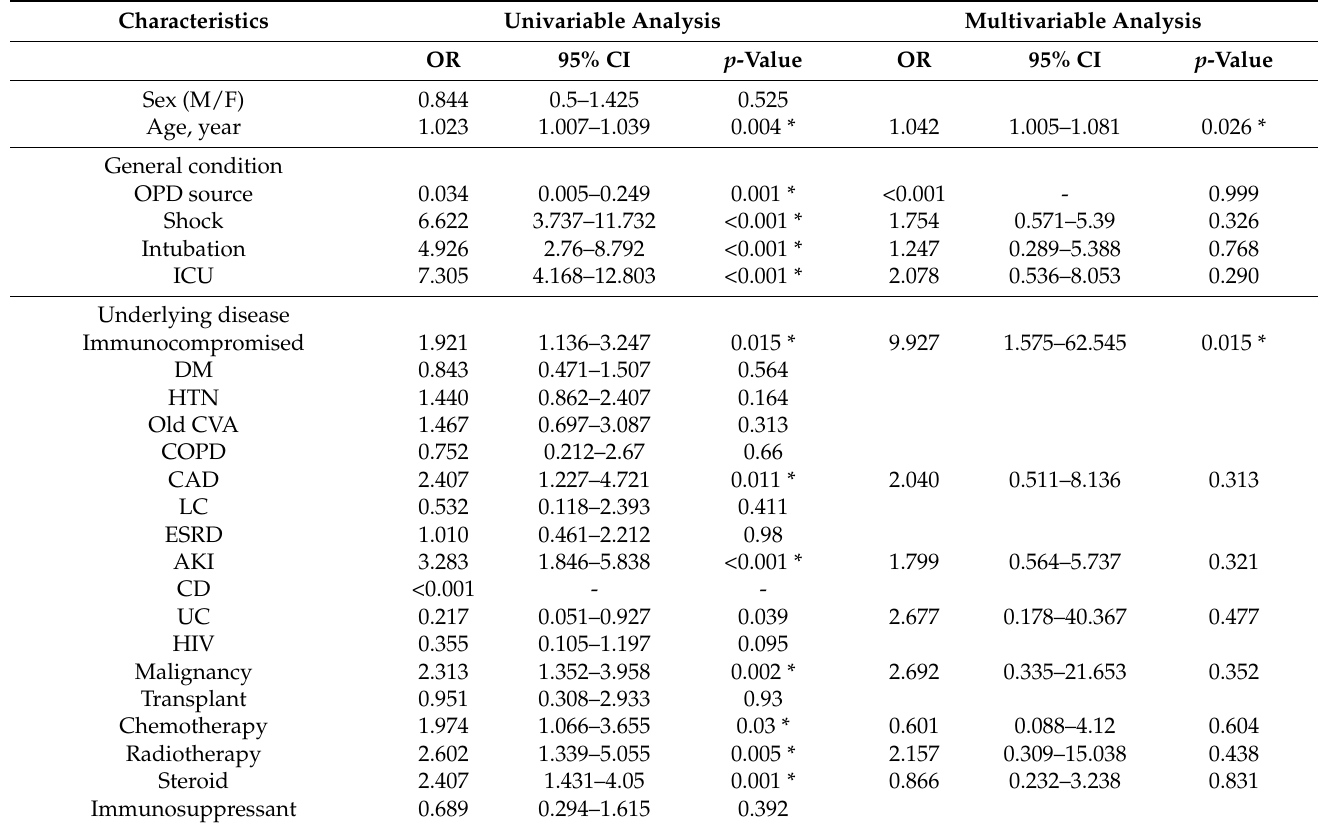
Table 2. Prognostic factors of in-hospital mortality for CMV GI